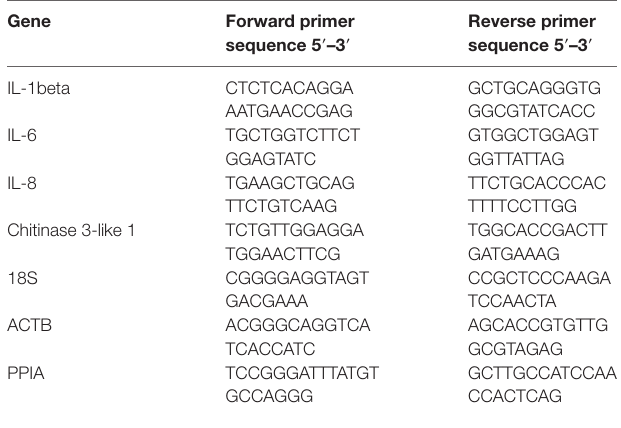
Table 1 | Primers used for